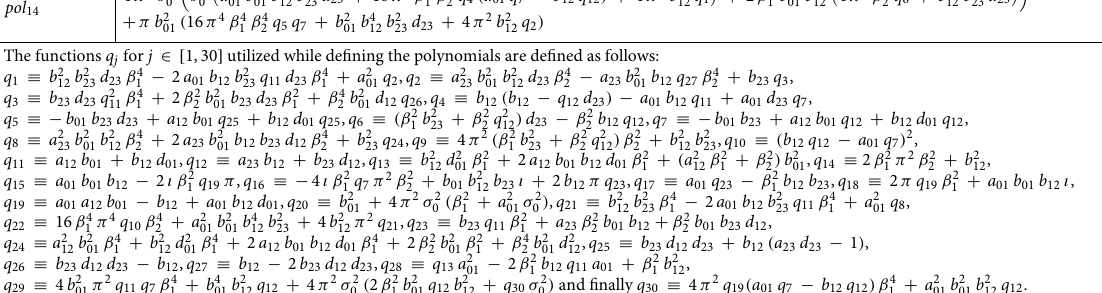
3 and Gaussian source with σ 0 ( b =